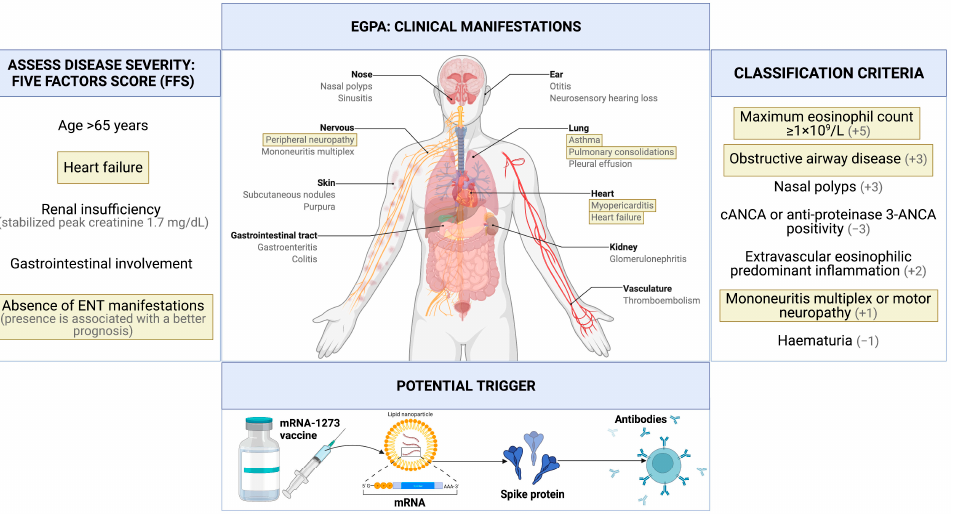
Figure 3. Graphical representation of clinical manifestations, items of the Five Factors Score (FFS) and ACR/EULAR classification criteria present in the described clinical case (highlighted in yellow).